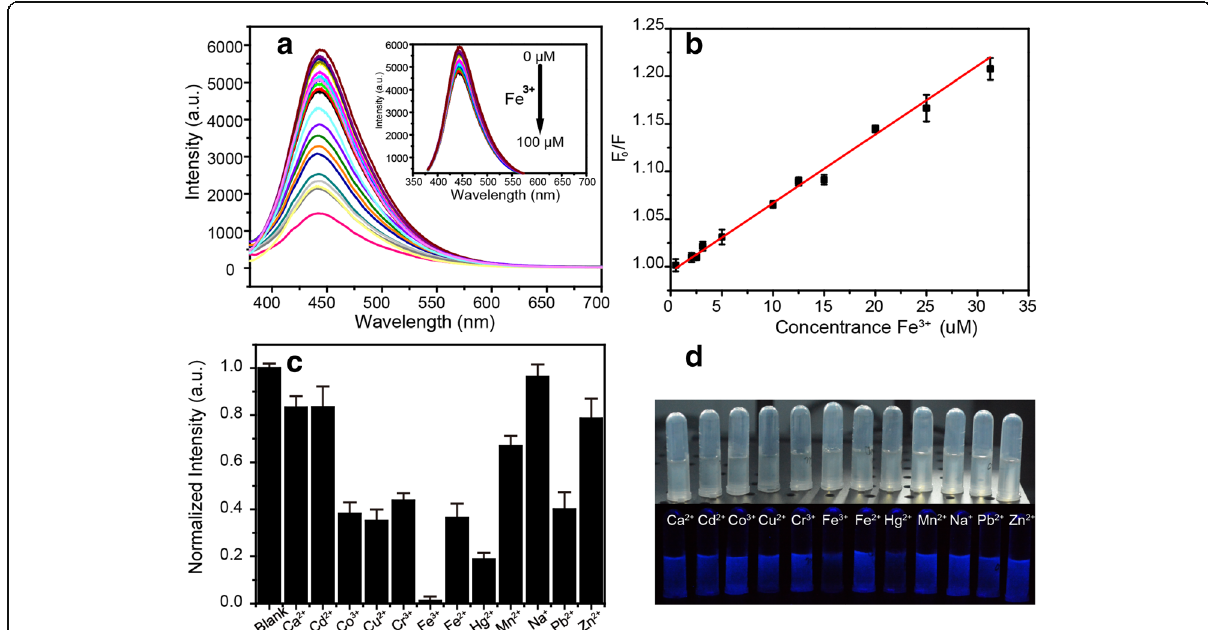
Fig. 5 a PL spectra of the NBDs in the presence of different concentrations of Fe 3 + . b Calibration curve of the sensor as a function of Fe 3 + concentration. c Fluorescence intensities of the NBDs in the presence of different ions. d Photographic images of the NBDs solution with different metal ions under indoor and UV